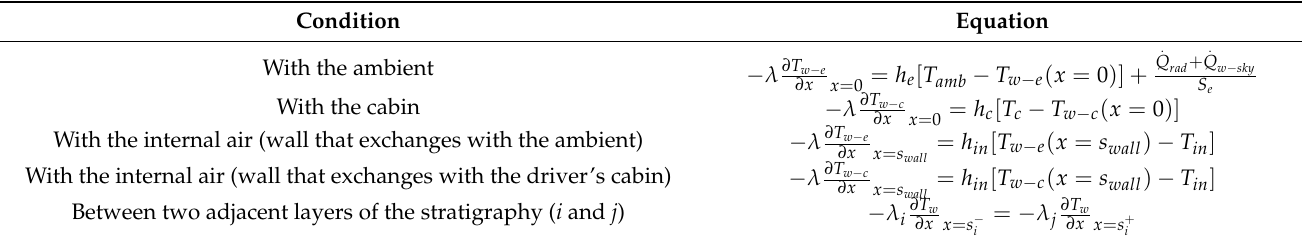
Table A6. Boundary